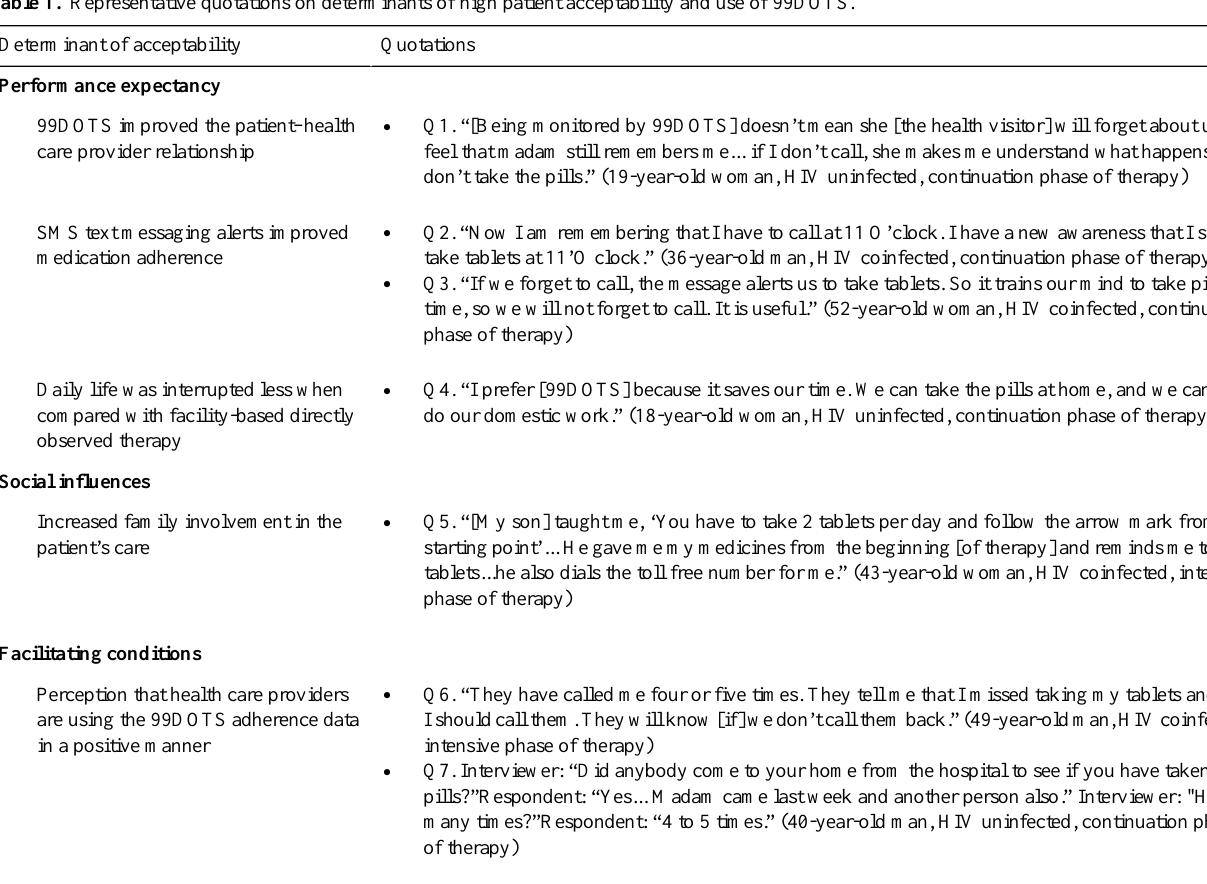
Table 1. Representative quotations on determinants of high patient acceptability and use of 99DOTS. QuotationsDeterminant of